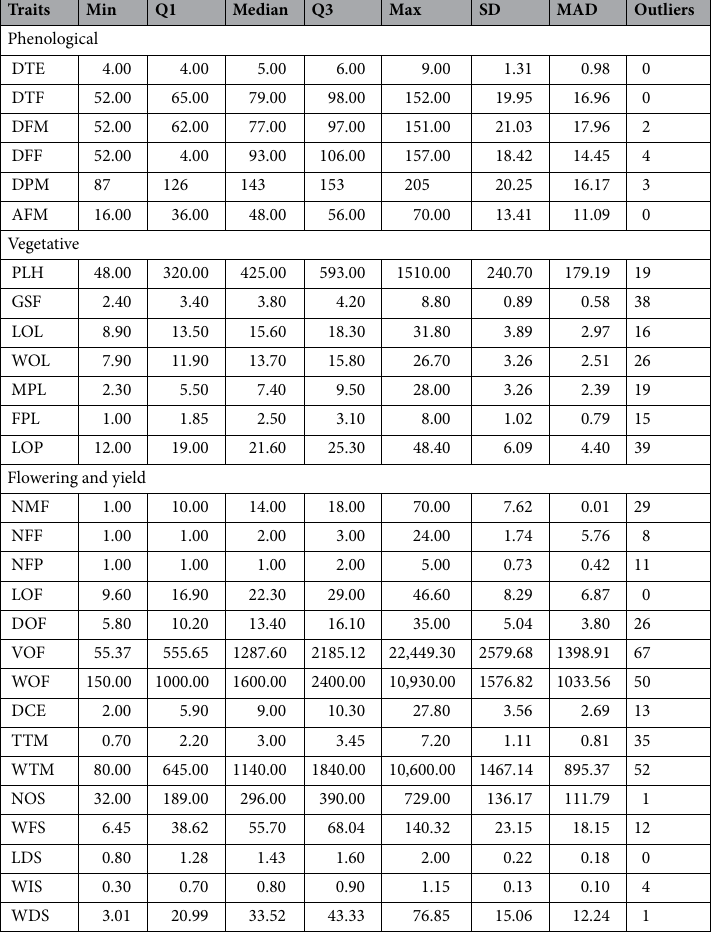
Table 2. Minimum (Min), first quartile (Q1), median, third quartile (Q3), maximum (Max), standard deviation (SD), median absolute deviation (MAD) and outliers obtained from the phenological, vegetative and flowering and yield traits of 663 accessions of C. moschata